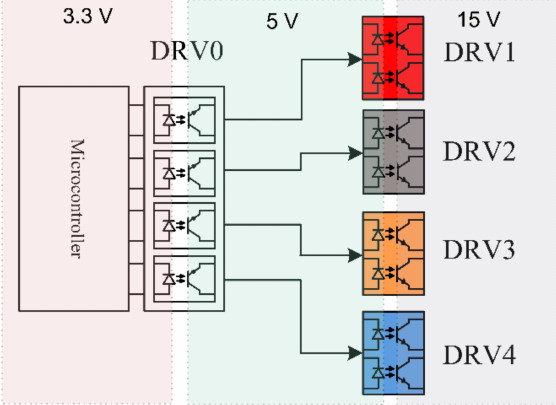
Figure 2. The block diagram of the driving circuit.